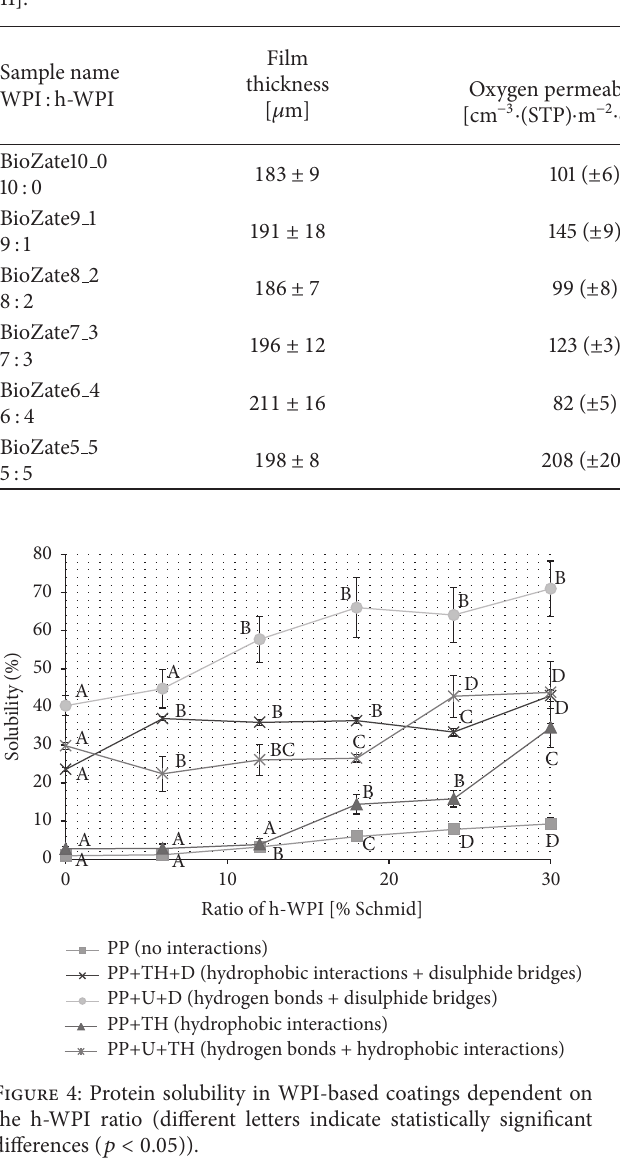
Table 4: Barrier properties for different ratios of h-WPI in WPI-based films and CLD with 95% confidence intervals (stated errors of OP indicate the distance to minimum and maximum values; different letters for WVTR indicate statistically significant difference ( 𝑝 < 0.05 )) [11].